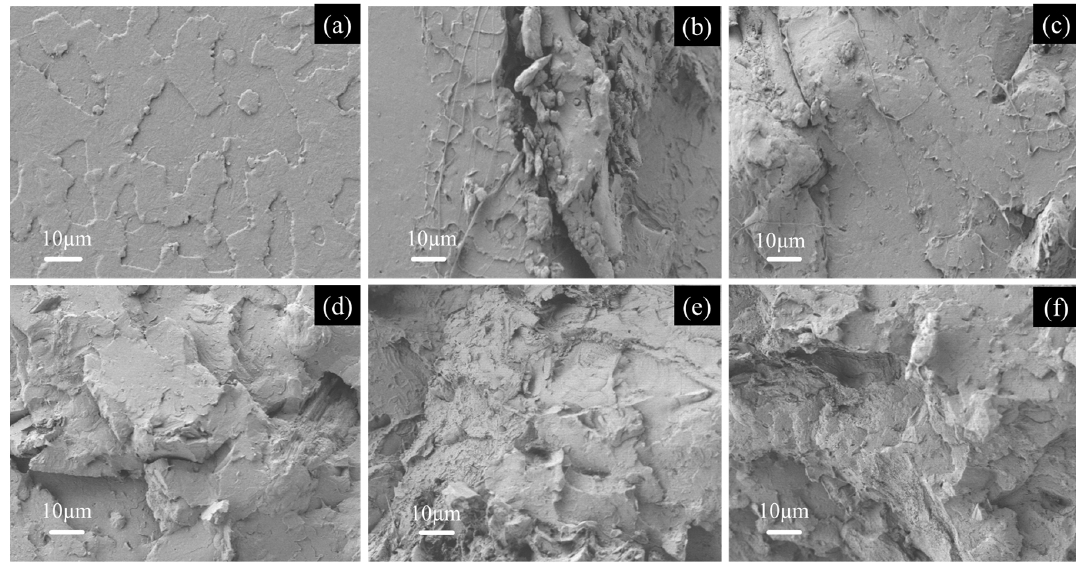
Figure 4. Field emission scanning electron microscopy (FESEM) images of the fracture surfaces of the injection-molded pieces of polylactide (PLA) with coffee husk flour (CHF) and torrefied coffee husk flour (TCHF): ( a ) Neat PLA; ( b ) PLA/20CHF; ( c ) PLA/20TCHF; ( d ) PLA/30TCH; ( e ) PLA/40TCH; ( f ) PLA/50TCH. Images were taken at 500× with scale markers of 10 µm.